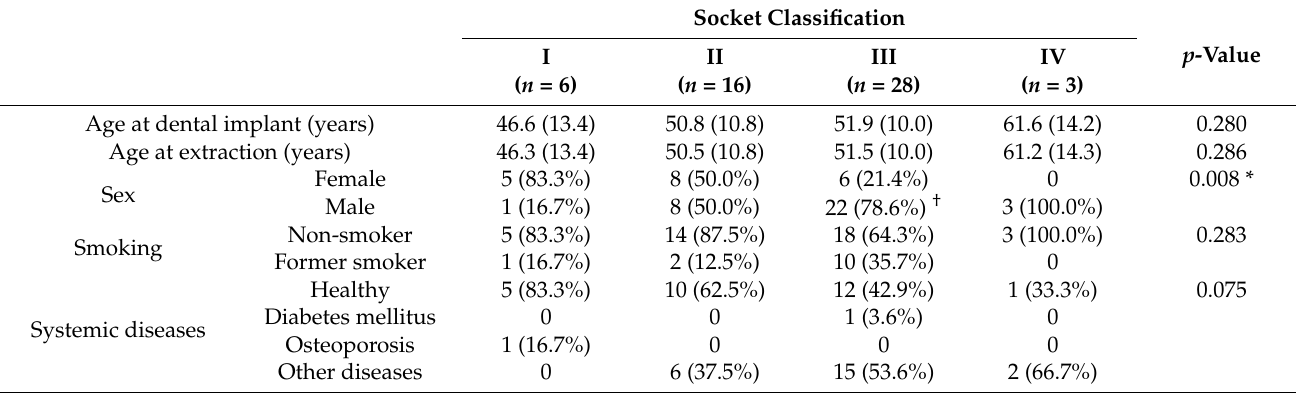
Table 1. Association of patients’ characteristics and socket classification for maxillary implants with flapless ridge